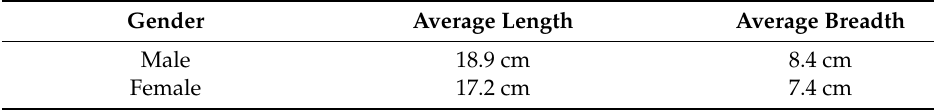
Table 1. The average dimension of the adult hands.